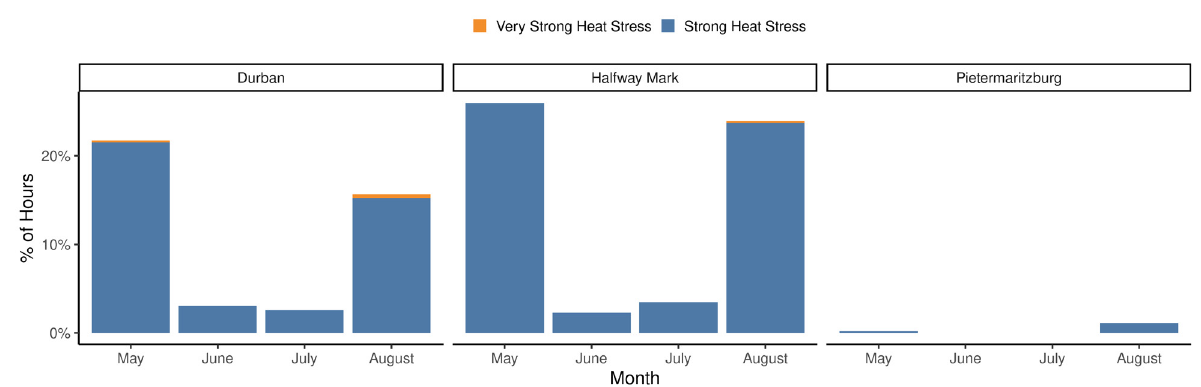
Figure 2: Distribution of ‘strong’ and ‘very strong’ heat stress hours between May and August (1980–2021) and location along the route. As a total of all WHO heat stress categories, ‘strong’ heat stress and ‘very strong’ heat stress days occur for only 11% of the total period.